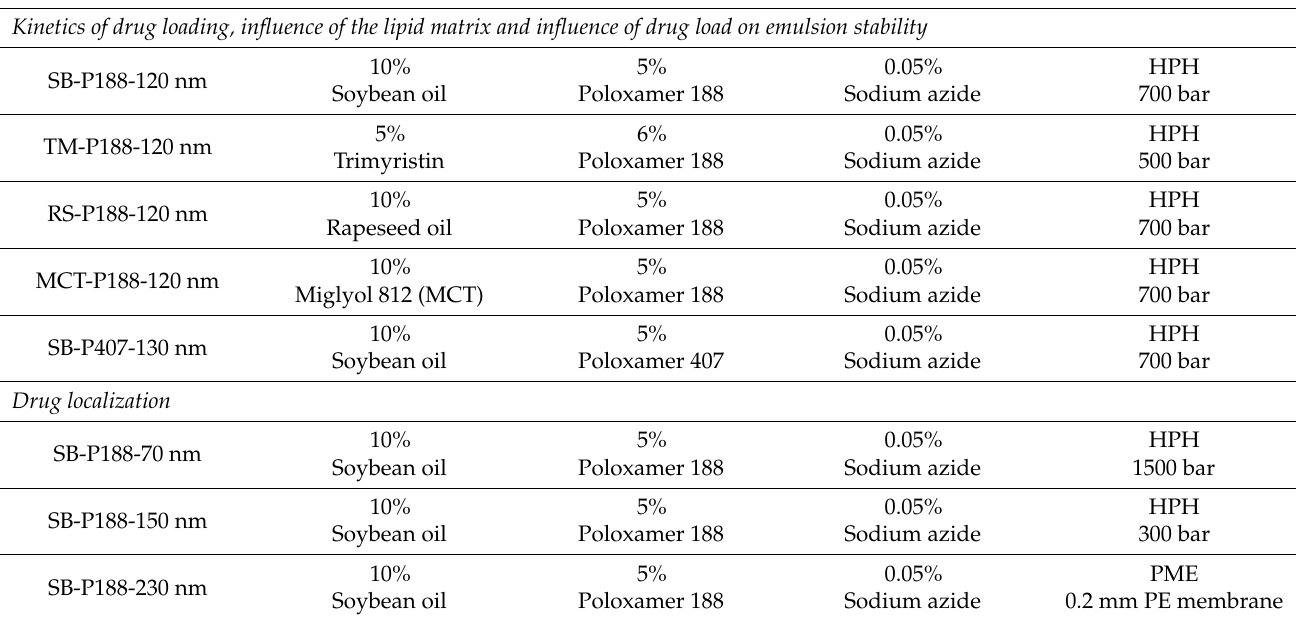
Process Parameters